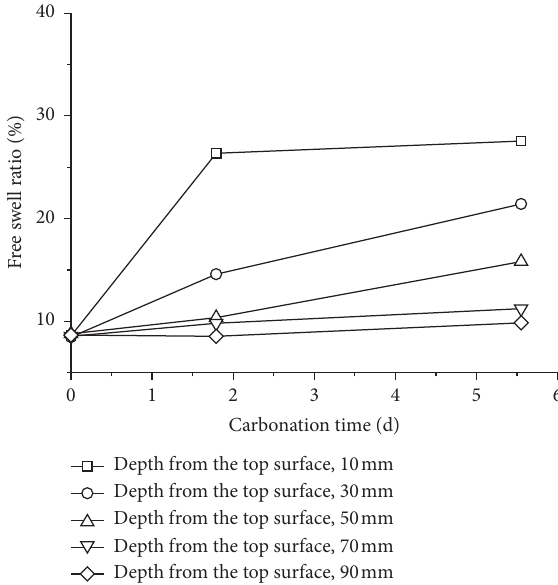
Figure 14: Evolution of free swell ratio with carbonation time and depth for lime-stabilized expansive soil.